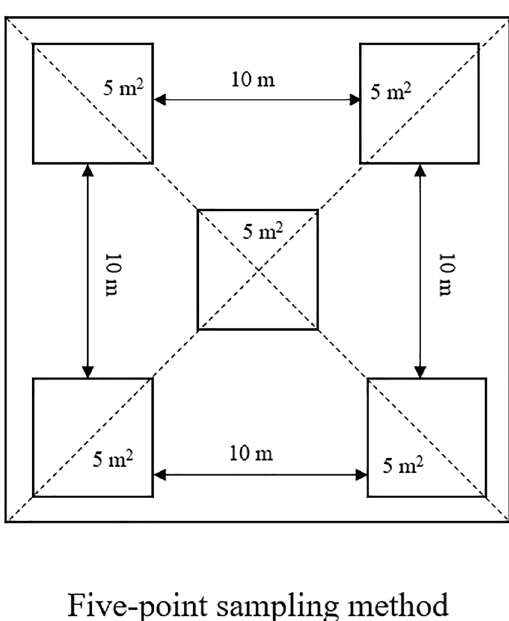
Figure 5. Five-point sampling